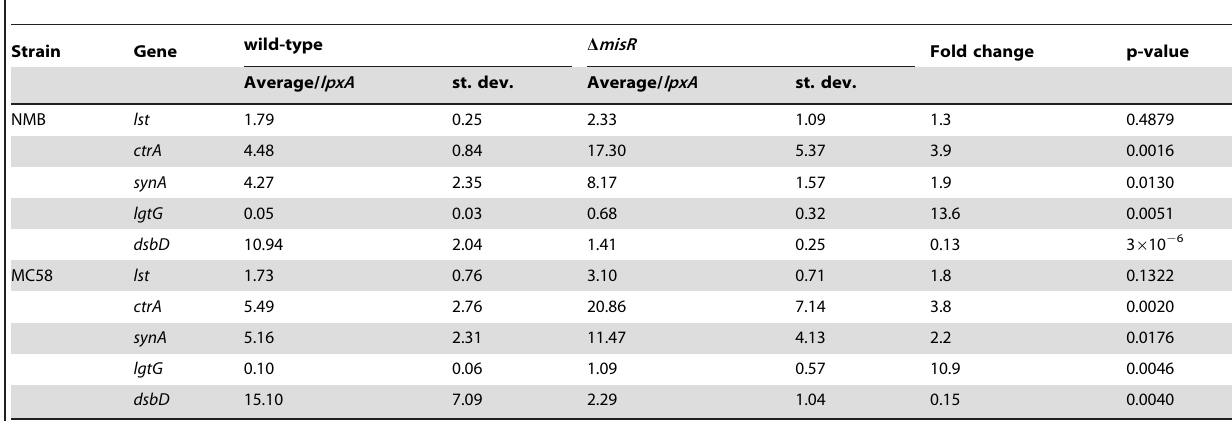
Table 4. qRT-PCR of gene expression in strains NMB-CDC and MC58 and their respective D misR mutants.